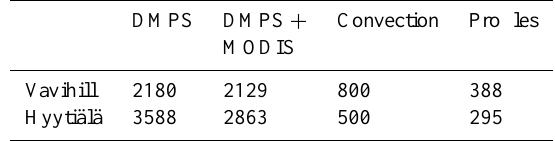
Table 3. Number of days in different steps of the data analysis. The columns from left to right show the number of days with: DMPS data, DMPS data and MODIS scenes simultaneously, convection present in the scene according to the manual investigation of the scenes and approved profiles included in the